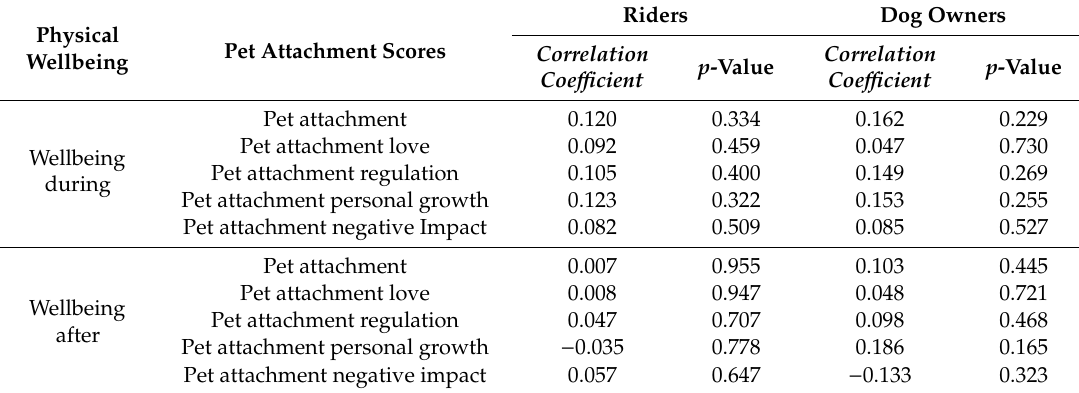
Table 3. Spearman correlation of physical wellbeing and pet attachment